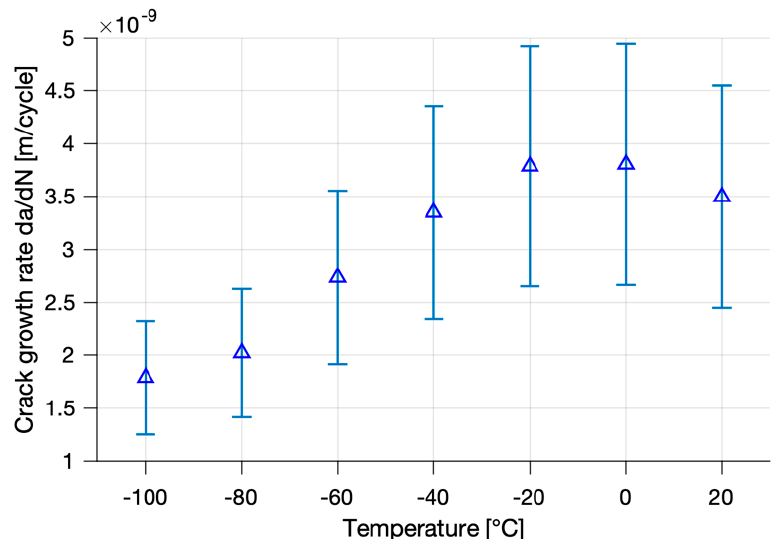
√ m of the S500 steel weld